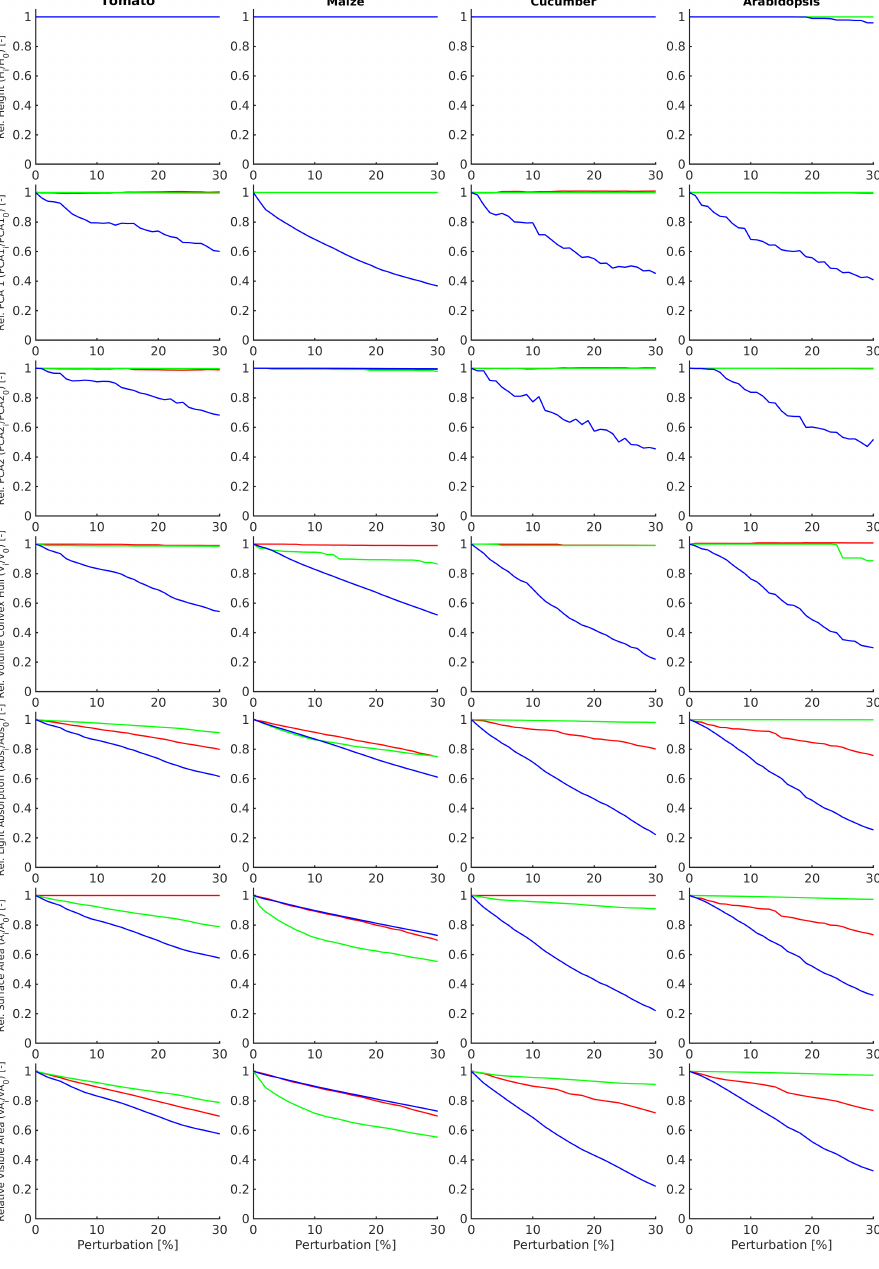
Figure 9. Summary of the simulated dependency of normalized phenotypic traits on the percentage of plant area loss for four different plant models and three different area perturbation scenarios including random (red), outside-to-inside (blue), and inside-to-outside (green) perturbation scenarios. The last row shows the dependency of the normalized visible plant area on the percentage of the total area loss for four plant models and the three alternative perturbation